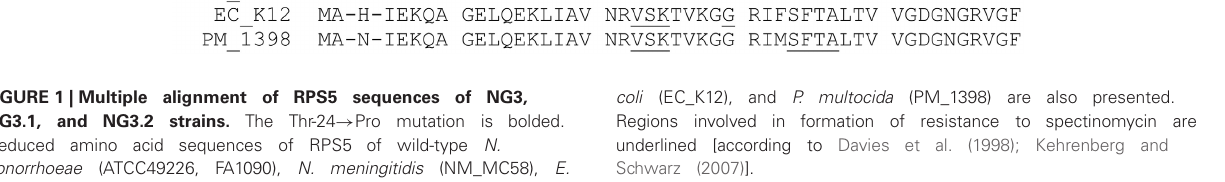
coli (EC_K12), and P. multocida (PM_1398) are also presented. Regions involved in formation of resistance to spectinomycin are underlined [according to Davies et al. (1998); Kehrenberg and Schwarz